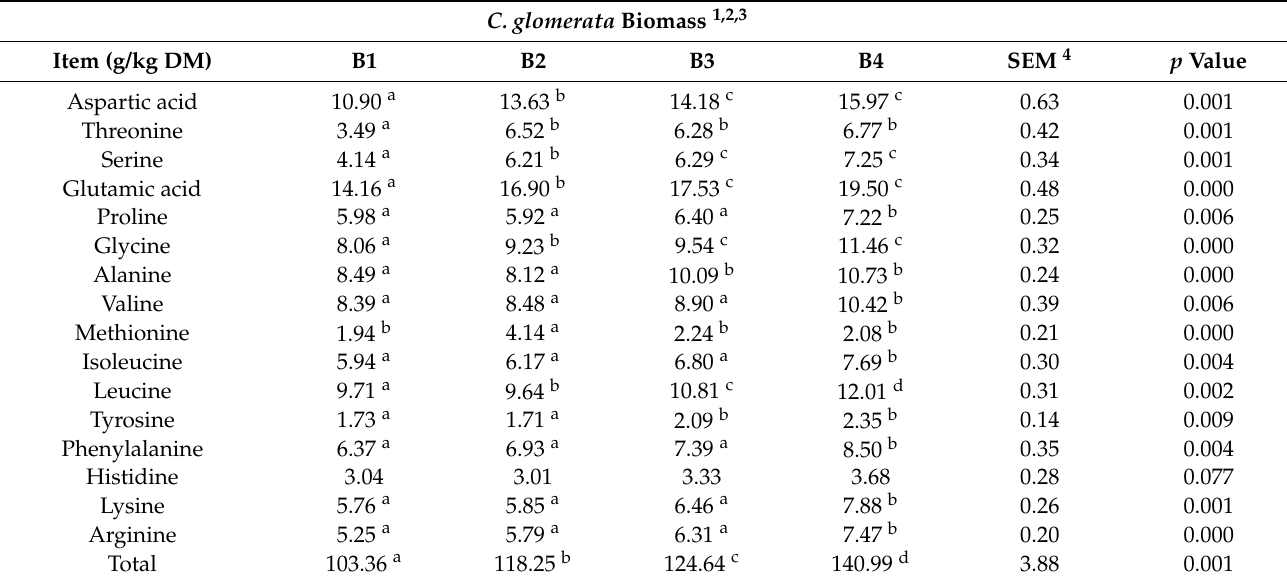
Table 4. Amino acids profile of C. glomerata biomass from different rivers in Lithuania. C. glomerata Biomass